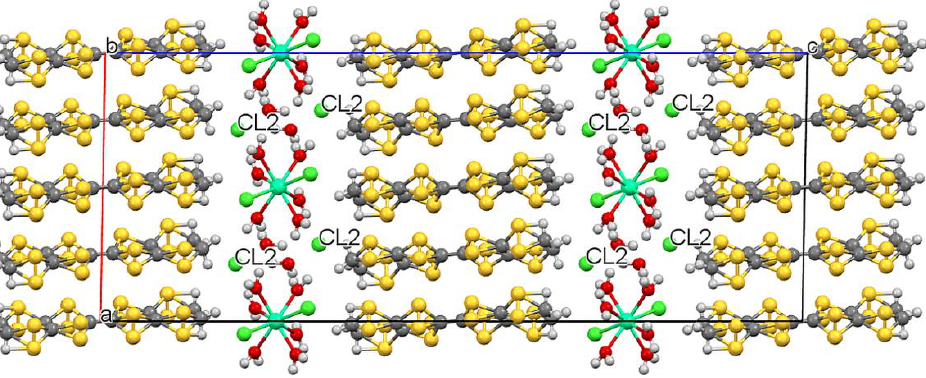
Figure 2. General view of the crystal structure of 1 . Organic and inorganic cation layers are interlinked by chloride anions Cl2.